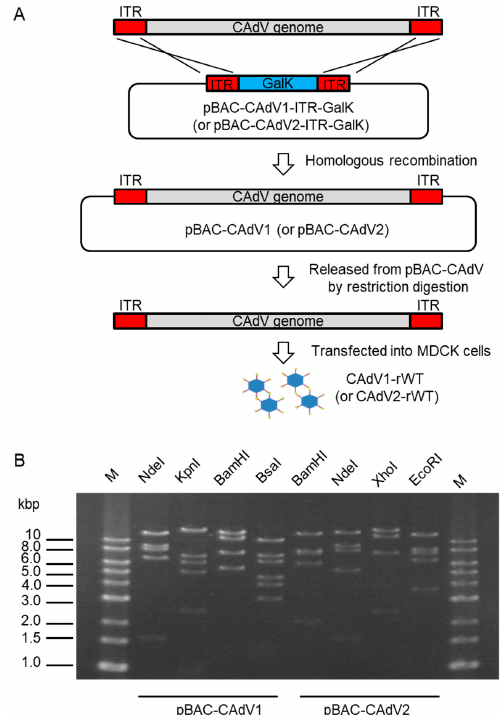
Figure 1. Cloning of canine adenovirus (CAdV) genomes into bacterial artificial chromosome (BAC) vectors. ( A ) CAdV1 (or CAdV2) DNA was introduced into SW102 cells harboring